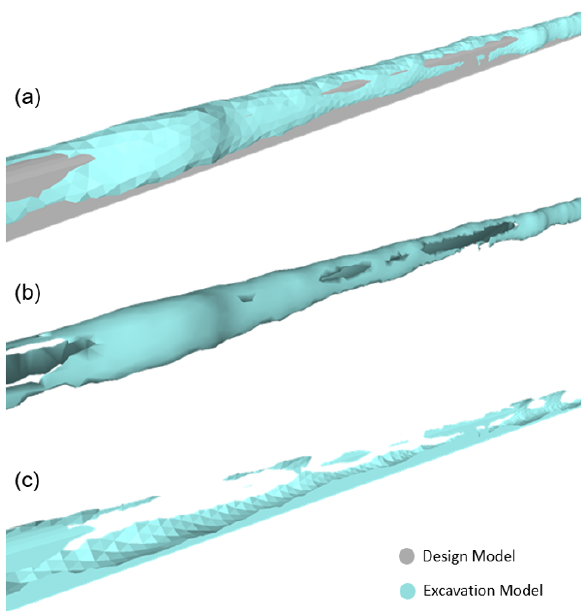
Figure 7. Excavation model evaluation. (a) The excavation model and the design model; (b) the overbreak model; (c) the underbreak